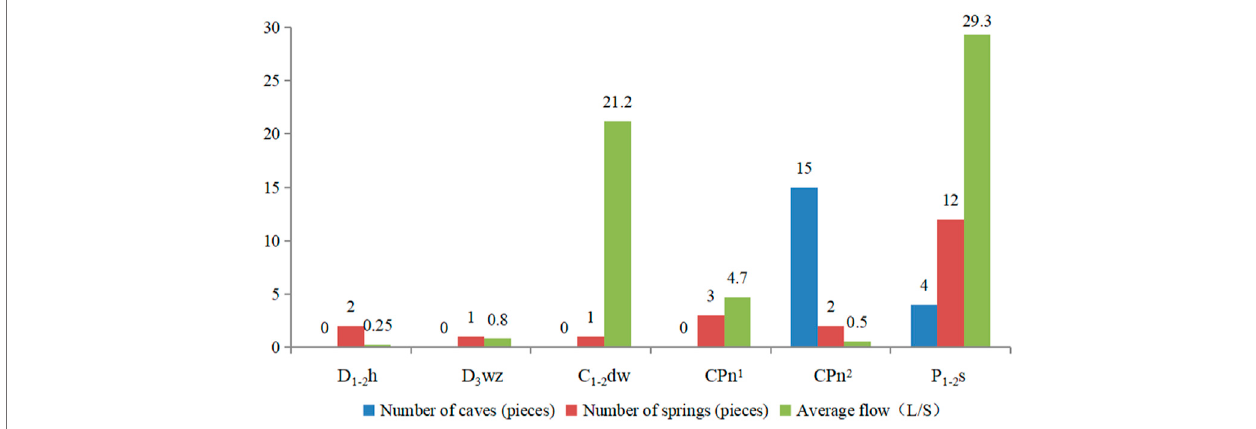
FIGURE 8 | Statistics on the number of karst caves and spring points and the average fl ow of spring in the different formations of Devonian Permian in the Qiannan area.